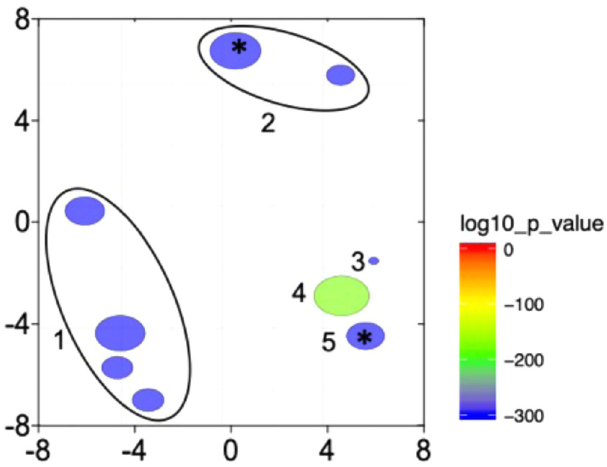
Fig. 3 Biological processes represented among the differentially expressed genes (DEGs). ReviGO two-dimensional representation of all GO terms represented among the total number of annotated DEGs ( n = 5509). The redundancy reduction fi lter was set to “ small ” (0.5). Each “ bubble ” represents a GO term; bubble color scales by the p -value determined by EdgeR (color scale, bottom right) and the bubble size indicates the frequency of the GO term in the underlying gene-ontology annotation database. Based on the Gene Ontology hierarchical organization, GO terms with the same GO parent have been circled (black line) and are indicated as a single number. GO term annotation: (1) Development/reproduction ( ‘ developmental process involved